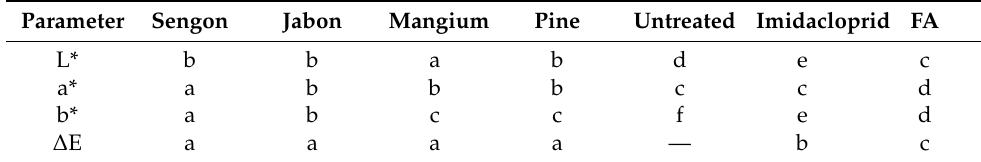
Figure 6. Wood specimens after 1-year of exposure in the field. Table 7. Duncan’s multiple range test for color values after